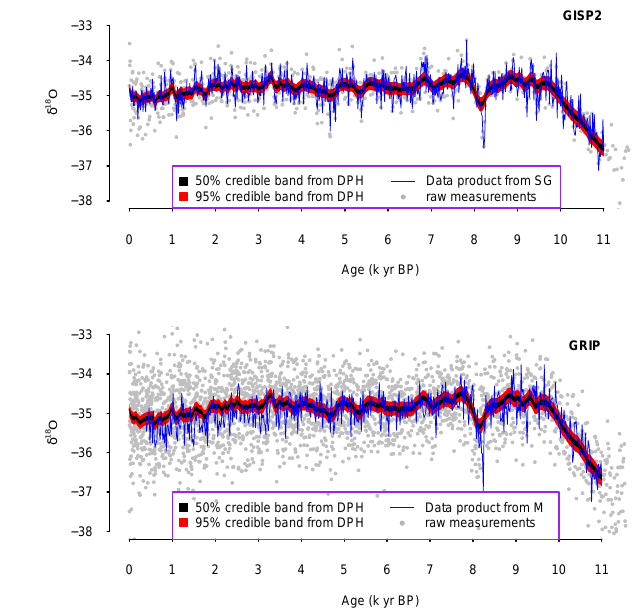
Figure5. Plotsofquantile-based50and95%credibleintervalsofthemarginalposteriordistributionsofprocess Figure 5. Plots of quantile-based 50 and 95% credible intervals of x g on a bidecadal time grid over the period of 0 to 11k cal BP conditional on both GISP2 and GRIP. We also the marginal posterior distributions of process x g on a bidecadal showthebidecadaldataproductreportedinStuiverandGrootes(2000,SG)andMogensen(2001,M). time grid over the period of 0 to 11kcalBP conditional on both GISP2 and GRIP. We also show the bidecadal data product reported in Stuiver and Grootes (2000, SG) and Mogensen (2001, M).